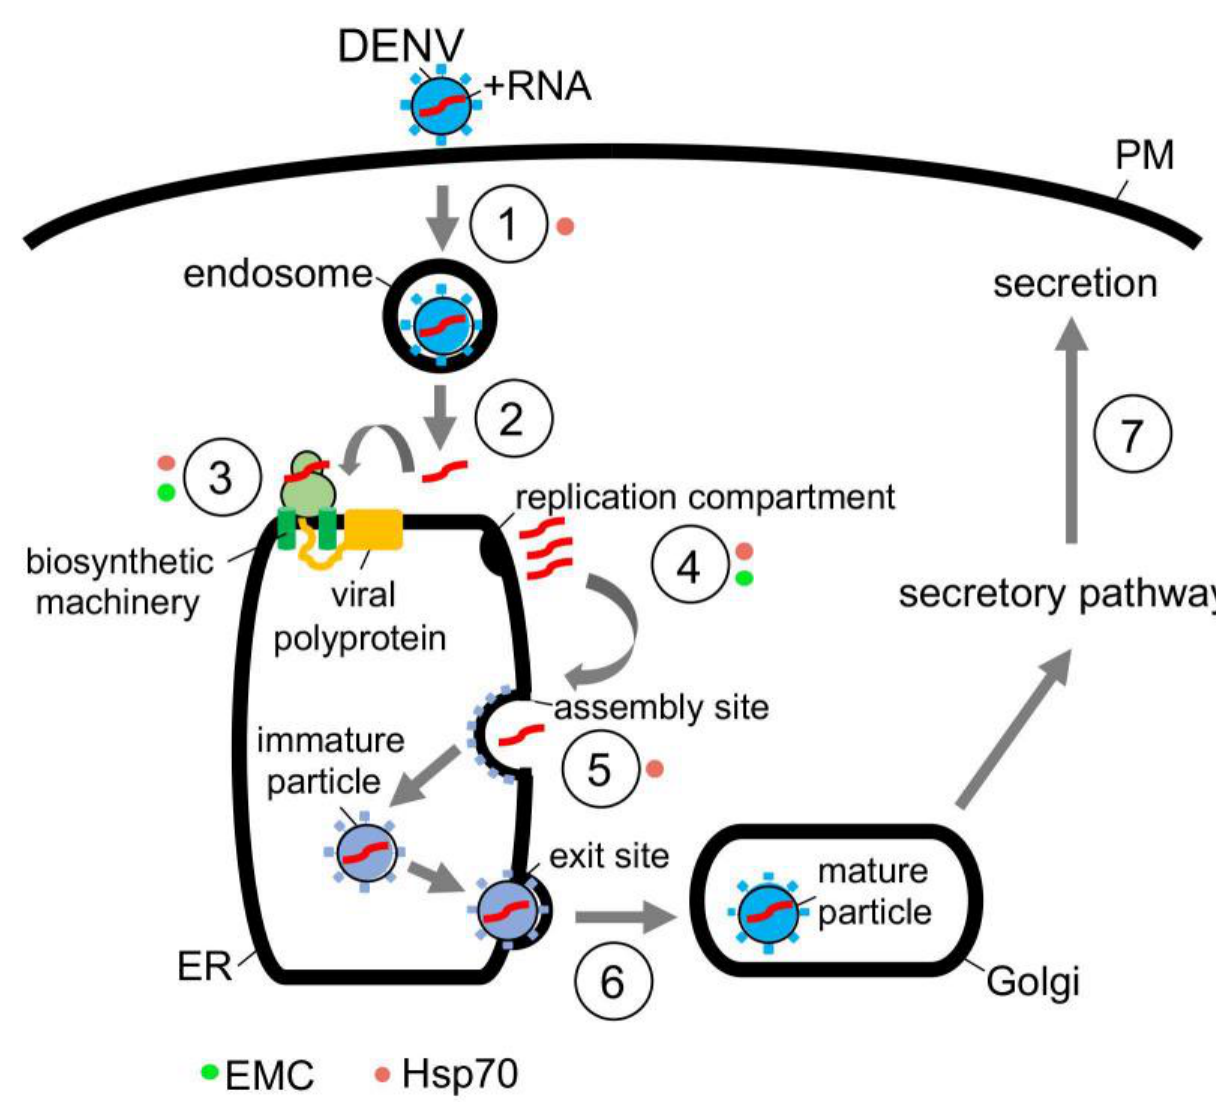
Figure 3. Hijacking cytosolic and ER-localized chaperones to promote flavivirus infection. Flavivirus DENV entry pathway (see text for more details). Hsp70 chaperone, in concert with J proteins, facilitate virus endocytosis, protein biosynthesis, and assembly. Hsp70 is proposed to mediate endocytosis of the incoming DENV particle ( step 1 , orange circle ), but how this is accomplished remains unclear. In contrast, Hsp70 binds directly to the NS5 RNA polymerase in order to promote biosynthesis and function of this enzyme ( step 3, orange circle ), thereby indirectly facilitating viral replication ( step 4, orange circle ). Hsp70 also interacts with and stabilizes the C protein to support viral assembly ( step 5, orange circle ). In addition to cytosolic Hsp70, the ER membrane protein complex EMC likewise contributes to DENV infection by assisting in biosynthesis of the nonstructural membrane proteins NS4A and NS4B ( step 3, green circle ). Since NS4A and NS4B are important for formation of the virus replication compartment ( step 4, green circle ), EMC thus supports virus replication